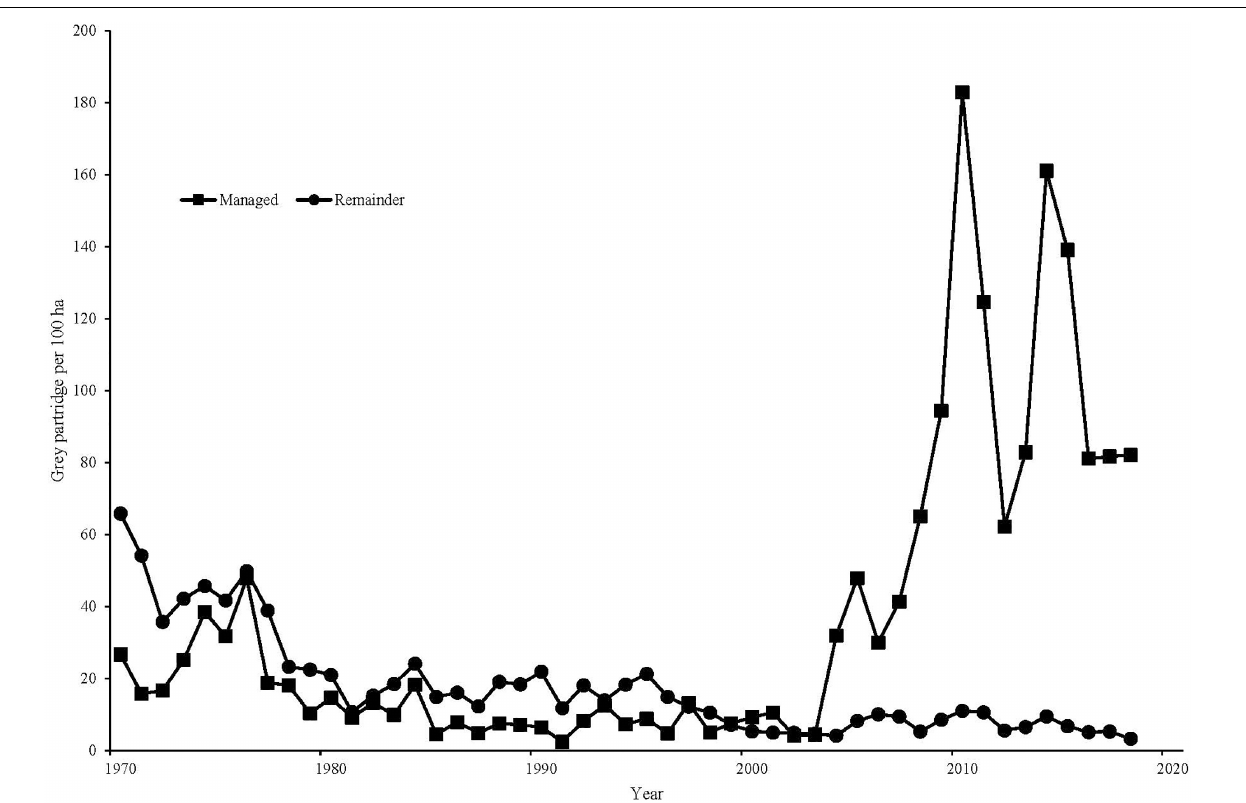
FIGURE 4 | Autumn counts (pairs/100 ha) of gray partridges, on the GWCT’s Sussex Study area, 1970–2018. Squares represent the land specifically managed for gray partridges from the mid-2000s. Circles represent land not subjected to partridge-specific